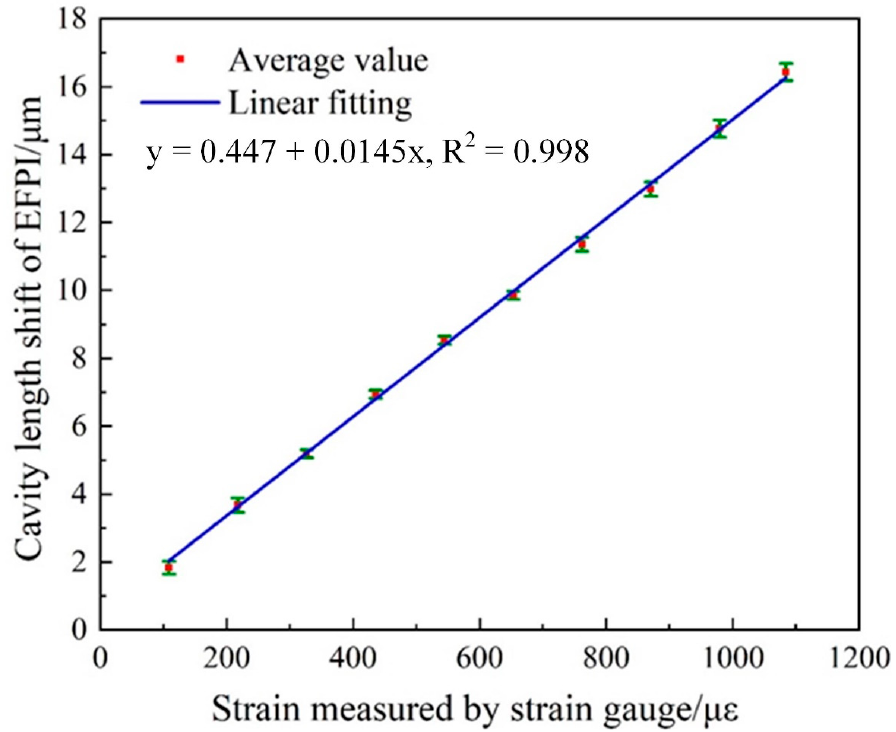
Figure 10. Cavity length shift ( ∆ d 2 ) of the air-cavity EFPI versus reference strain measured by the commercial strain gauge.